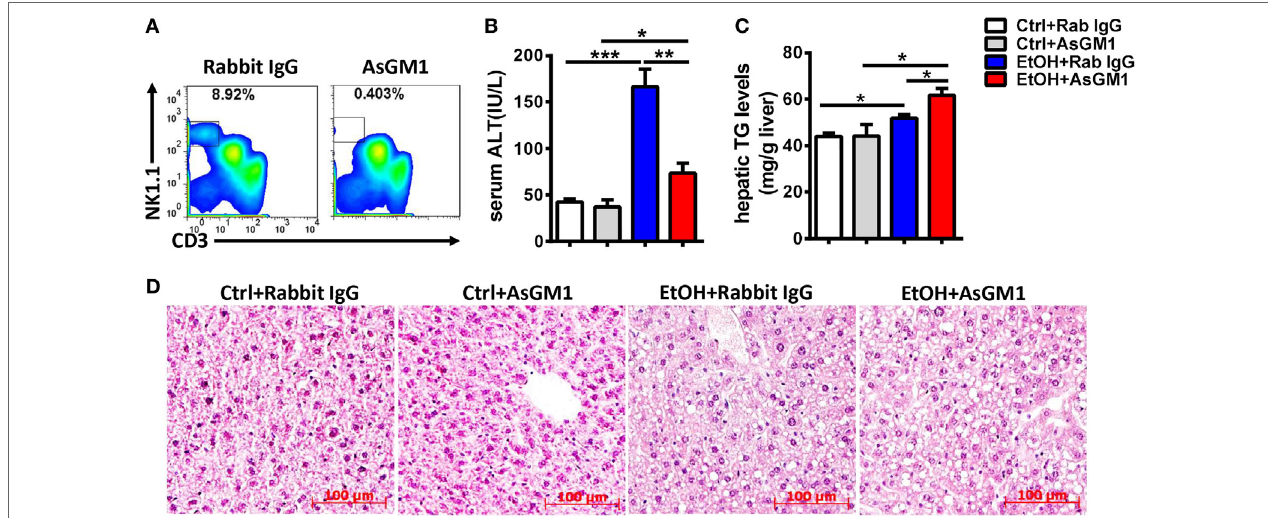
FigUre 1 | Deficiency of natural killer (NK) cells promoted liver steatosis but ameliorated inflammation in a chronic-binge model. Pair- or ethanol-fed wild-type C57BL/6 mice were treated with anti-asialo GM1 or control rabbit IgG once every 3 days as described in Section “Materials and Methods” to deplete NK cells. The mice were euthanized 9 h after gavage. (a) Liver mononuclear cells were isolated, and the depletion efficiency was verified by flow cytometry; liver injury and steatosis were evaluated based on (B) serum alanine aminotransferase and (c) liver triglyceride levels and (D) liver tissue hematoxylin and eosin staining (original magnification, 200 × ). The data are representative of two independent experiments and are shown as the mean ± SEM ( n = 4–6). * P < 0.05; ** P < 0.01; *** P <